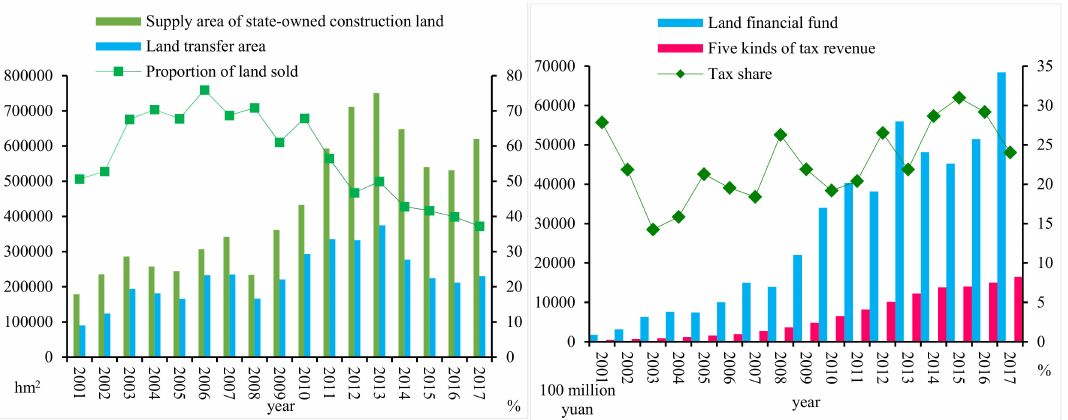
Figure 3. Scale and proportion of tax revenue in state-owned construction land, land transfer area, and land financial